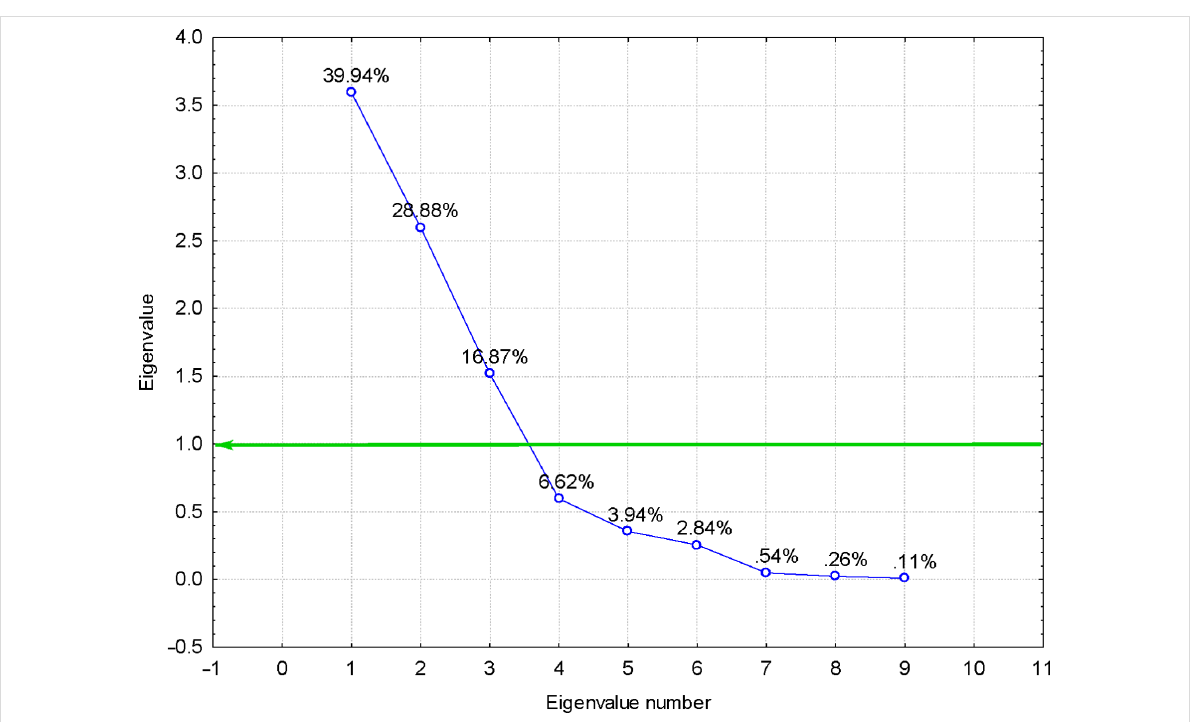
Figure 12: Eigenvalues of the correlation matrix from the FTIR–PCA analysis of the β -CD/hazelnut oil/flavonoid ternary complexes and flavonoids; only wavenumbers of the FTIR bands were used as input variables (see Table S12 in Supporting Information File 1 for codes); the first three PCs can be retained, which explain 85.69% from the variance of the